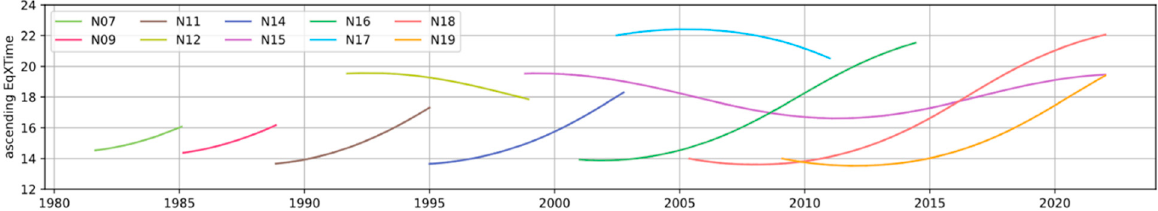
Figure 1. Local equator crossing times (LEXTs) of the ascending half-orbits for the NOAA satellites processed in RAN2. (From the NOAA 3S system [23,24]).